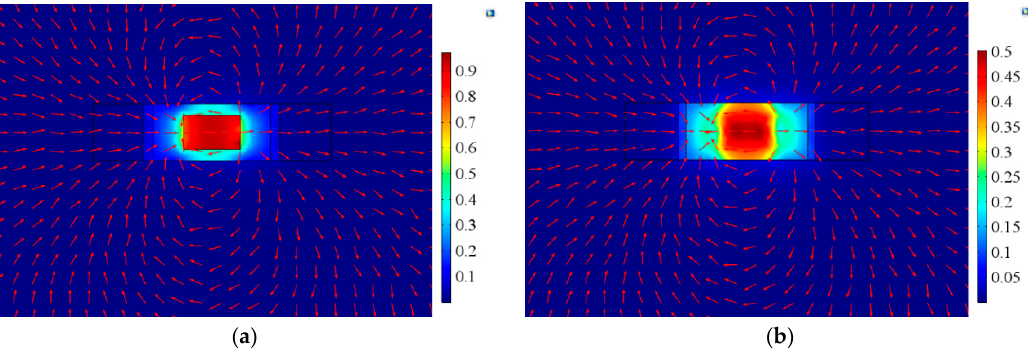
( b ) Figure 18. Magnetic flux distribution on ( a ) the upper and ( b ) lower surfaces of Terfenol-D under under two NdFeB permanent magnets. Based on the above analysis, we can conclude that when the position of the permanent magnet is different, the magnetic field environment of the structure is different. The elongation of Terfenol- D is closely related to the applied magnetic field. Hence, when the permanent magnet is placed in different positions, it will affect the elongation of the entire Terfenol-D, which is the cause of the ME effect of the structures. As a consequence, the ME coefficient of the entire structure is different when the permanent magnet is placed in different positions. 4. Conclusions In summary, the influence of NdFeB magnets on the ME effect in A-line shape Terfenol-D/PZT structures was investigated in this paper. The ME coefficient at different frequencies has been studied for the ME structures with ABS and mica trestles. The experimental results indicate that multiple resonance peaks exist in the A-line shape structures. The response frequencies are significantly affected by the position of the NdFeB permanent magnet in the ME structures. The maximum ME coefficient for ABS+ case was 4.142 V/A at 32.2 kHz, which is 60.3% of that at H DC = 79.6 kA/m. For the ME structures with mica trestles, the ME coefficient maintained high values in the frequency domain 65~87 kHz. Fast Fourier analysis of voltage transient curves showed that the phenomenon of